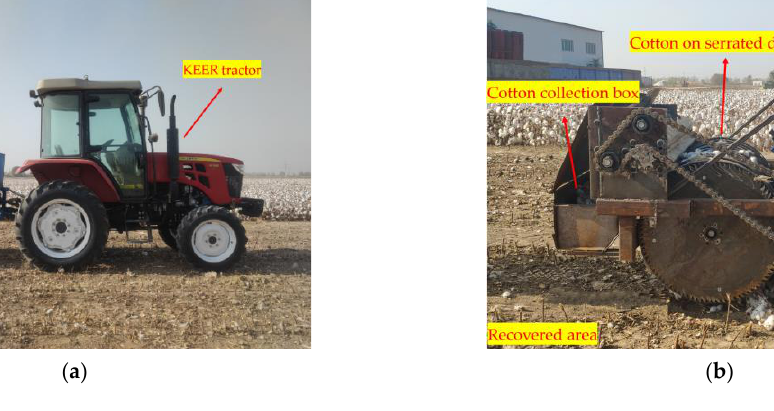
Figure 11. Field test of the experimental device. ( a ) Field test. ( b ) Device operation effect.